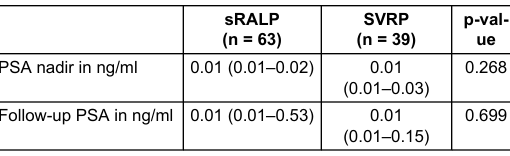
Table 2: Oncological outcome after standard robotic assisted laparo- scopic radical prostatectomy (sRALP) compared with seminal vesicle- sparing radical prostatectomy